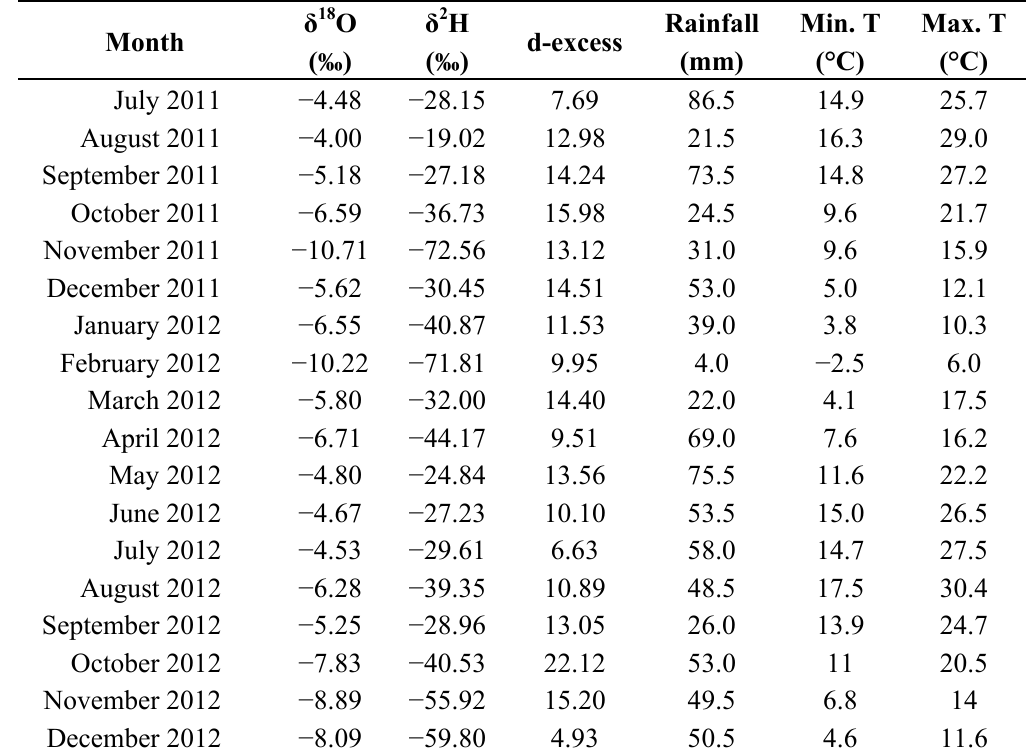
Table 1. Isotopic results, calculated d-excess and meteorological conditions for the rainfall samples near Toulouse.